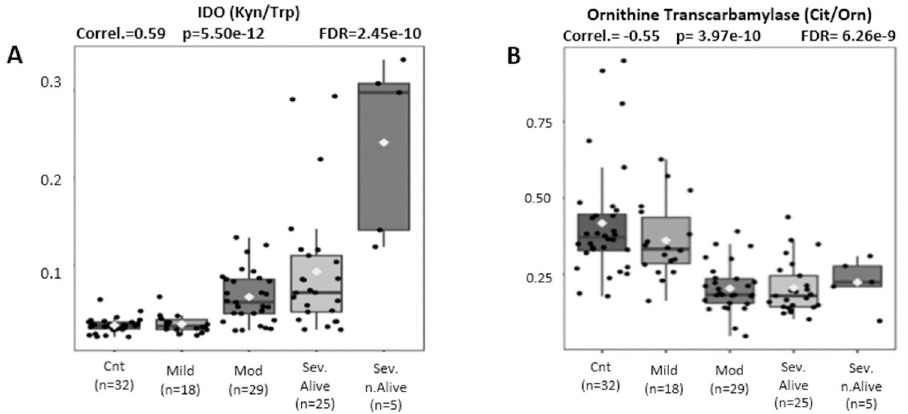
Fig 7. (A, B). Pearson Moment correlations of IDO activity (Kyn/Trp) and Ornithine transcarbamylase activity (Cit/ Orn) for disease severity comparing controls, mild, moderate, and severe Covid patients.